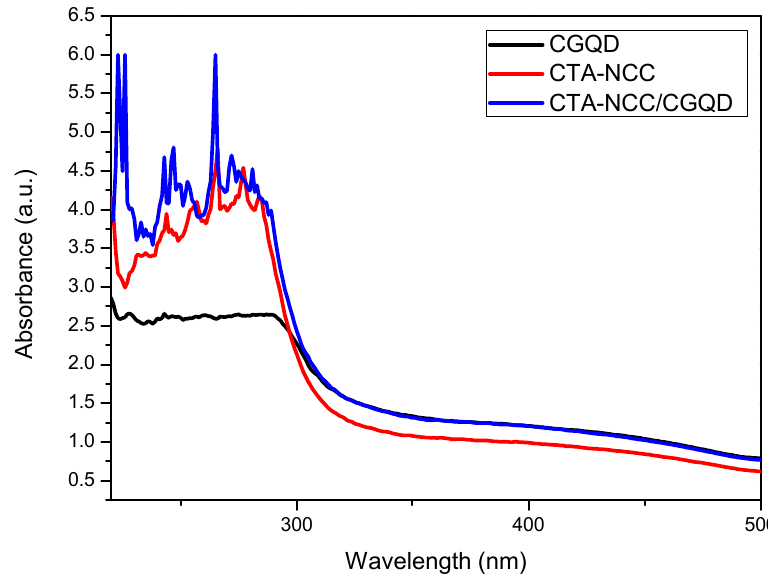
Figure 5. Absorbance spectrum of CGQD, CTA-NCC and CTA-NCC / CGQD thin film.